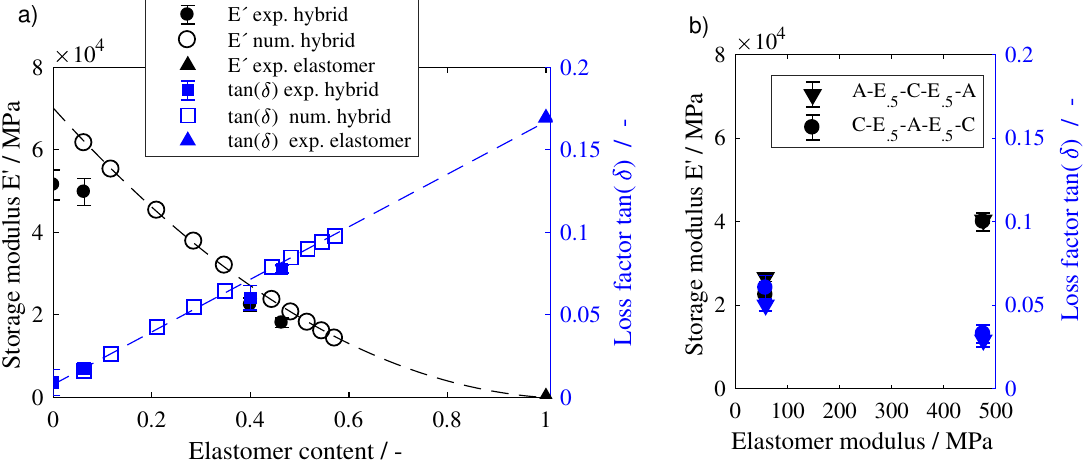
Figure 13. ( a ) Influence of elastomer content = (total thickness of both elastomer layers)/(thickness of specimen)) for a (C-El s -A-El s -C) lay-up; ( b ) experimental results for the influence of the elastomer